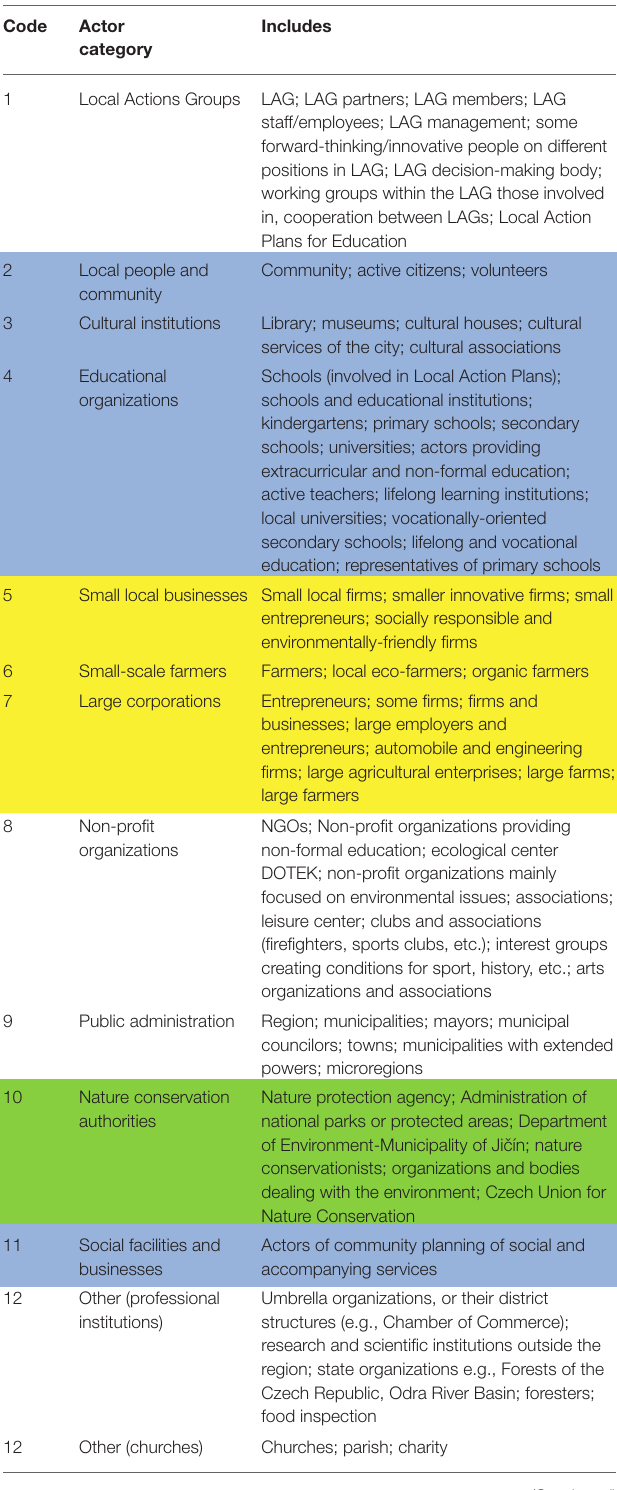
TABLE 1 | Definition of actor categories (theoretically based coding) and the summary of responses from open-ended questions.